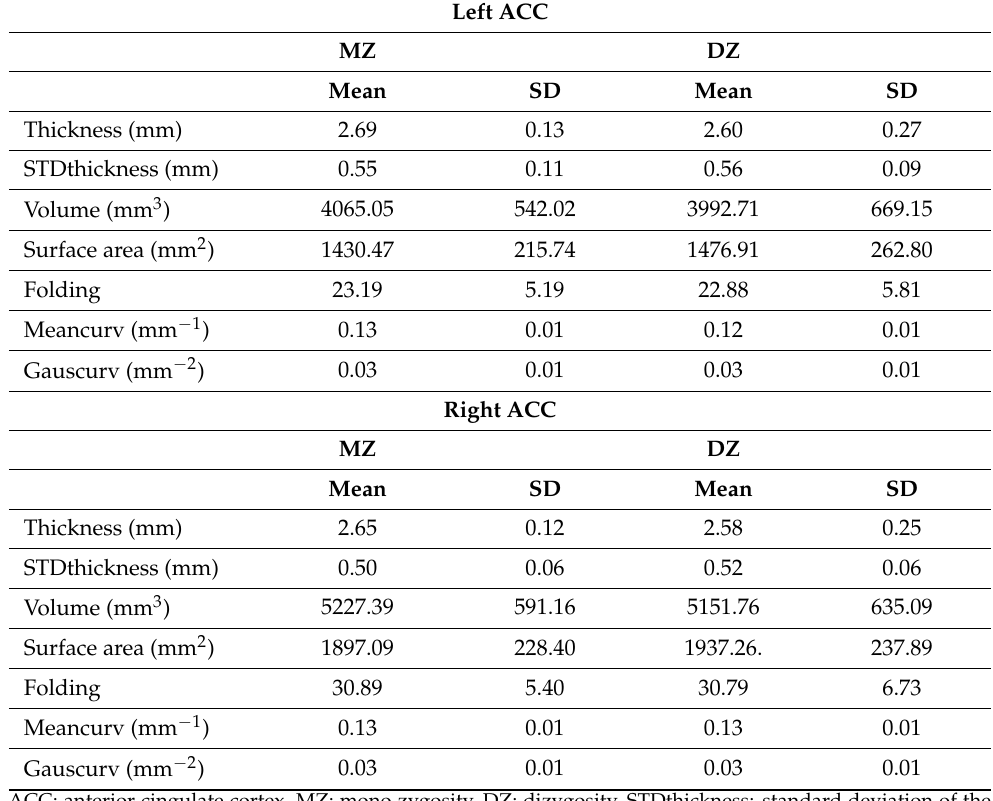
Table 3. Differences in surface morphological parameters in zygosity.